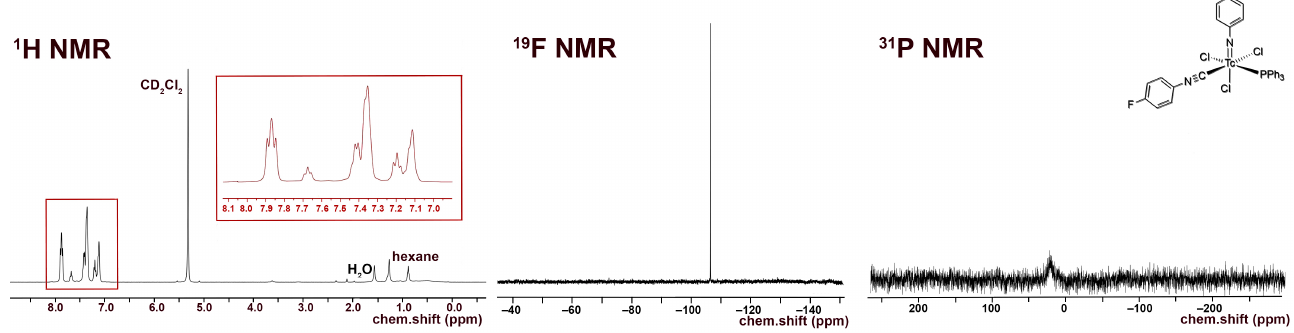
pF )] ( 6 ) in CD 3 (PPh 3 )(CNPh 2 Cl 2